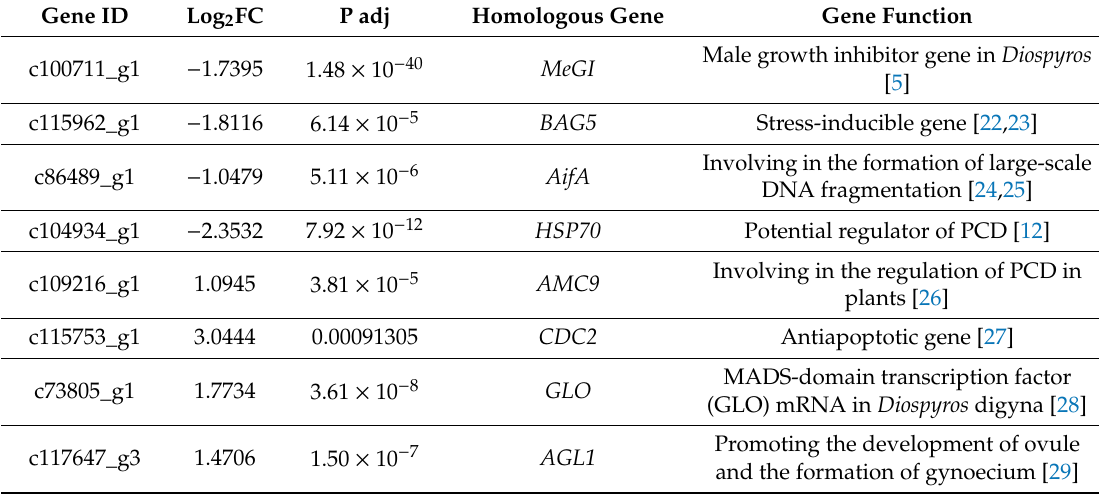
Table 2. Fold-changes and descriptions of genes in male vs female floral buds based on transcriptome sequences of persimmons.